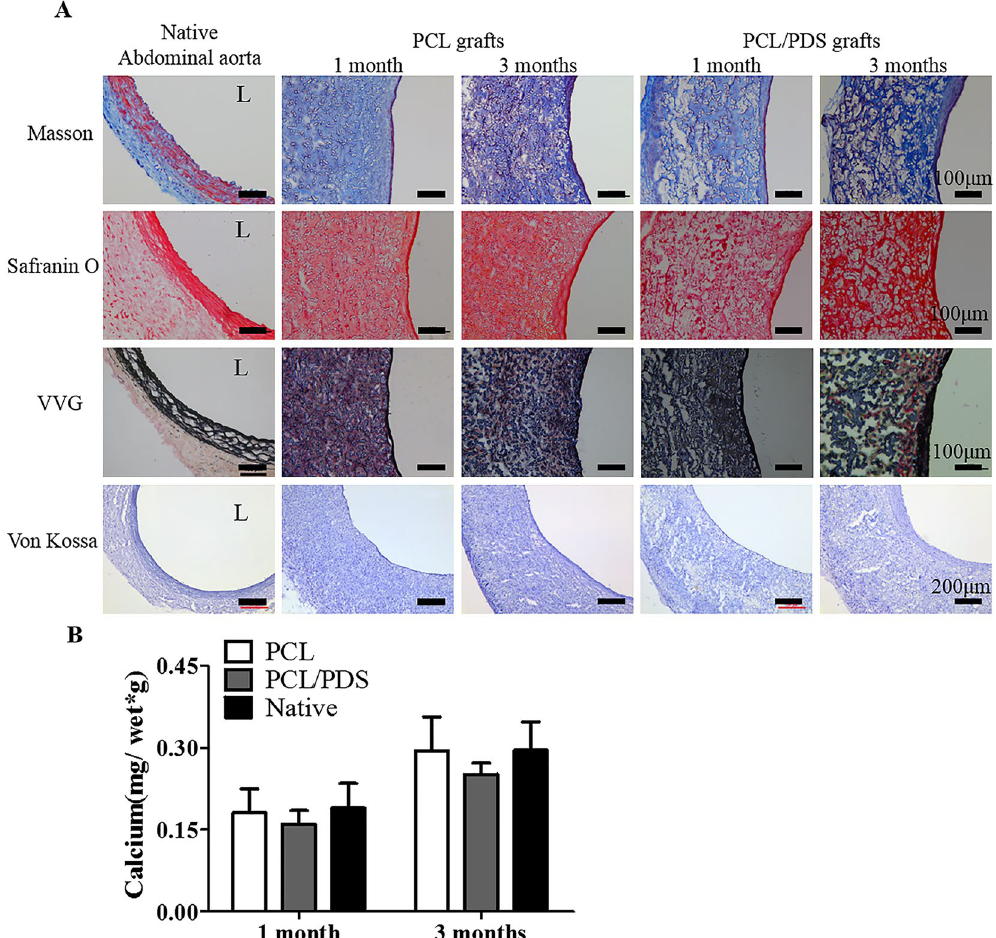
Figure 6. ECM reconstruction of explanted grafts at 1 and 3 months after implantation. ( A ) The cross sections were stained with Masson’s Trichrome, Safranin O, Verhoeff-Van Gieson (VVG) and Von Kossa to identify the presence of collagen, glycosaminoglycan, elastic fibers and calcification, respectively. ( B ) Atomic absorption spectrophotometer showed that the calcium concentrations of the explanted grafts were close to native abdominal